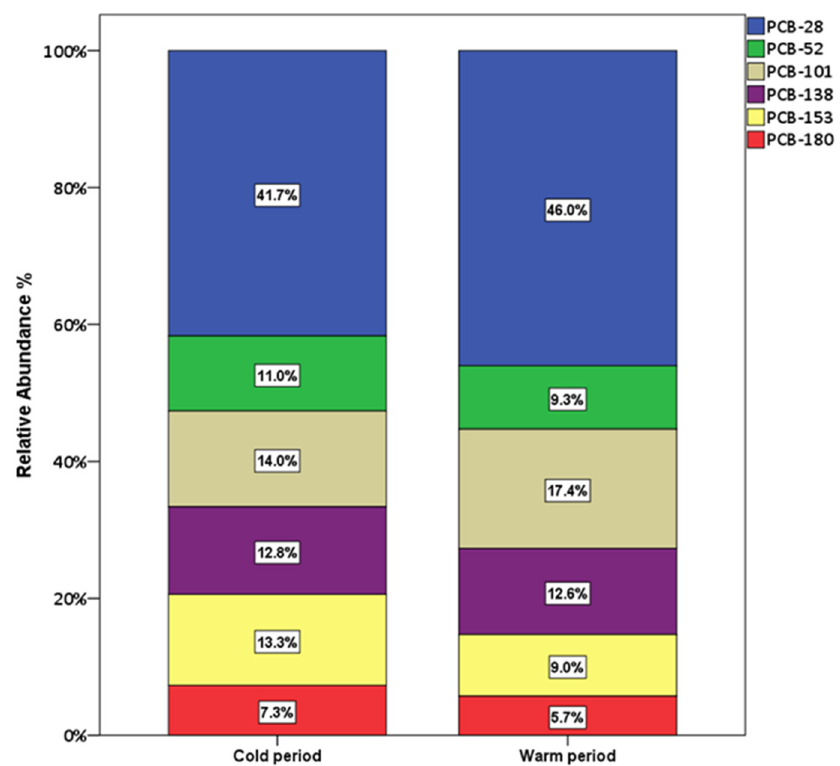
Figure 4. Relative abundance among indPCB congeners for the cold and warm periods.